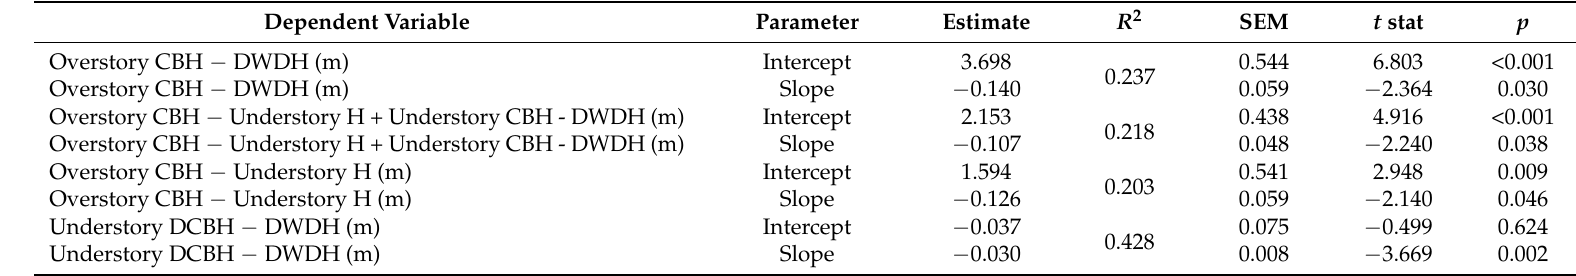
Table 3. Estimated linear model parameters of the space between measured stand structural components (dependent variables) by years of continuous spruce budworm defoliation (independent variable) from 1993–2008 in boreal mixedwood forest near Warren, Ontario: Host overstory crown and downed woody debris (Overstory CBH − DWDH); host overstory crown, host understory crown and downed woody debris (Overstory CBH − Understory H + Understory CBH − DWDH); host overstory and understory crowns (Overstory CBH − Understory H); and host understory dead crown base and downed woody debris (Understory DCBH − DWDH). Standard error of the mean is represented by